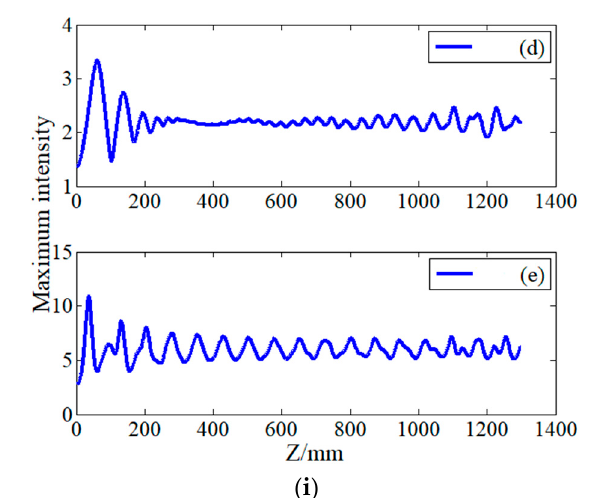
Figure 1. The propagation property of a 1D Airy beam in Kerr media with different initial amplitudes: ( a ) 𝐴 = 1 ; ( b ) 𝐴 = 1.5; ( c ) 𝐴 = 2 ; ( d ) 𝐴 = 2.5 ; ( e ) 𝐴 = 3.5 ; ( f ) 𝐴 = 4; ( g ) 𝐴 = 5; ( h ) 𝐴 = 6 ; and ( i ) is the maximum intensities of the beam in ( d , e ) versus propagation distance.